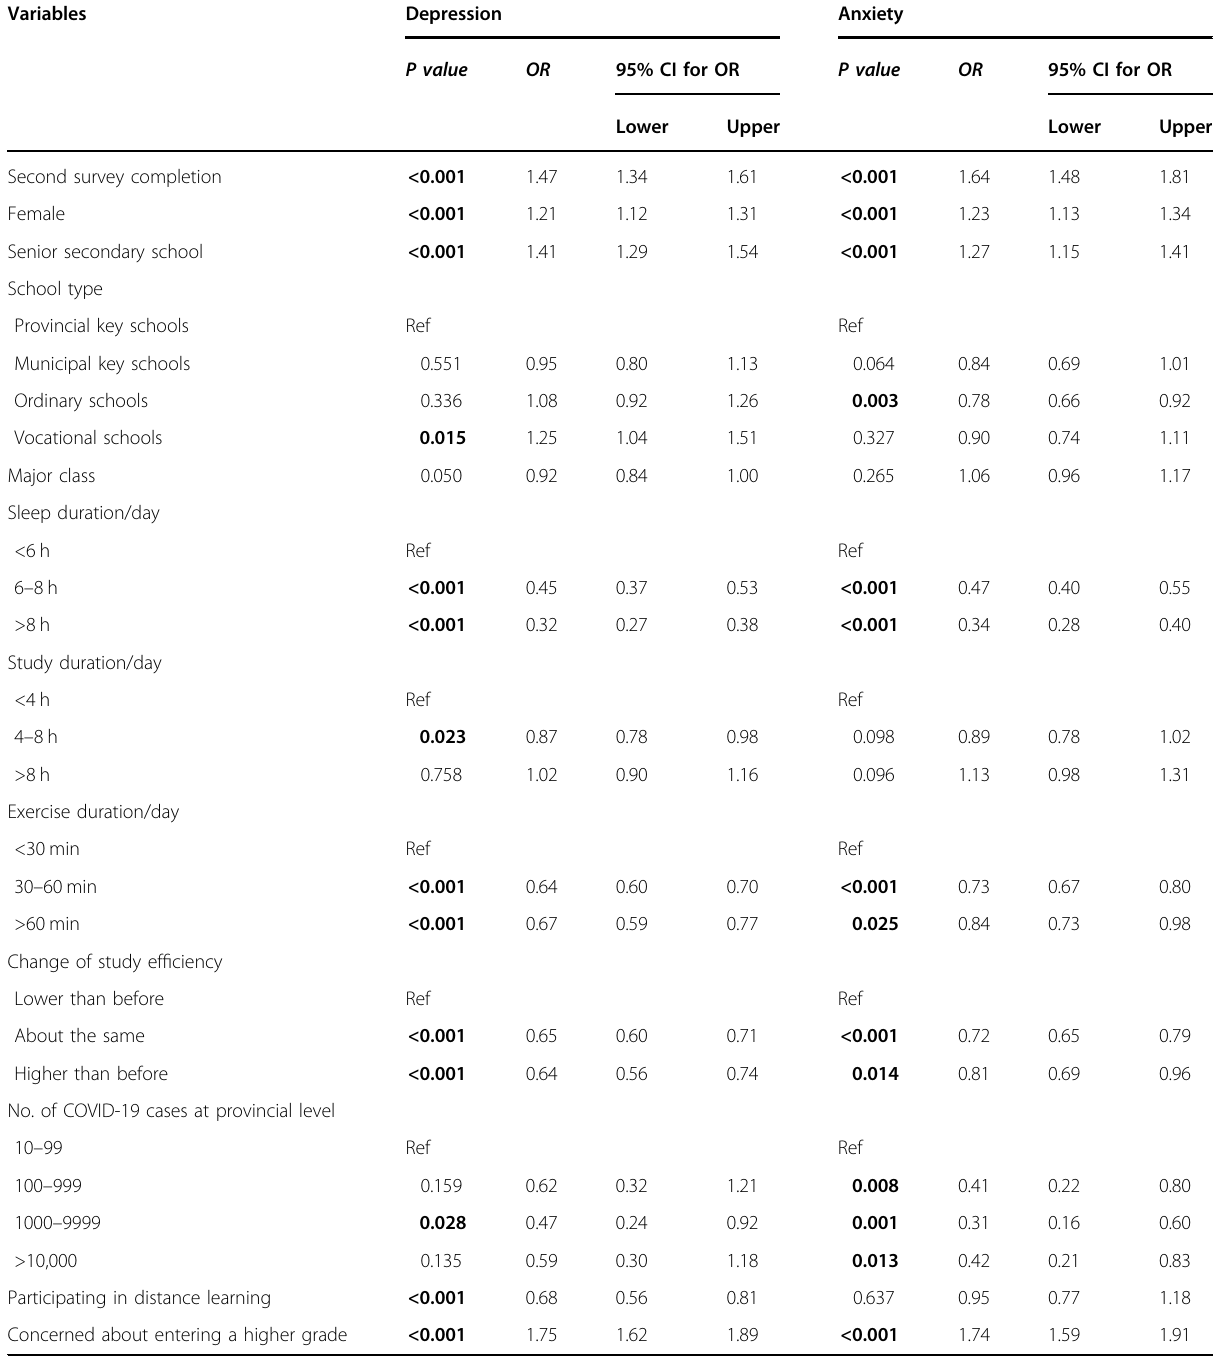
Table 3 Independent correlates of depression and anxiety of the whole sample ( n = 13,440). Variables